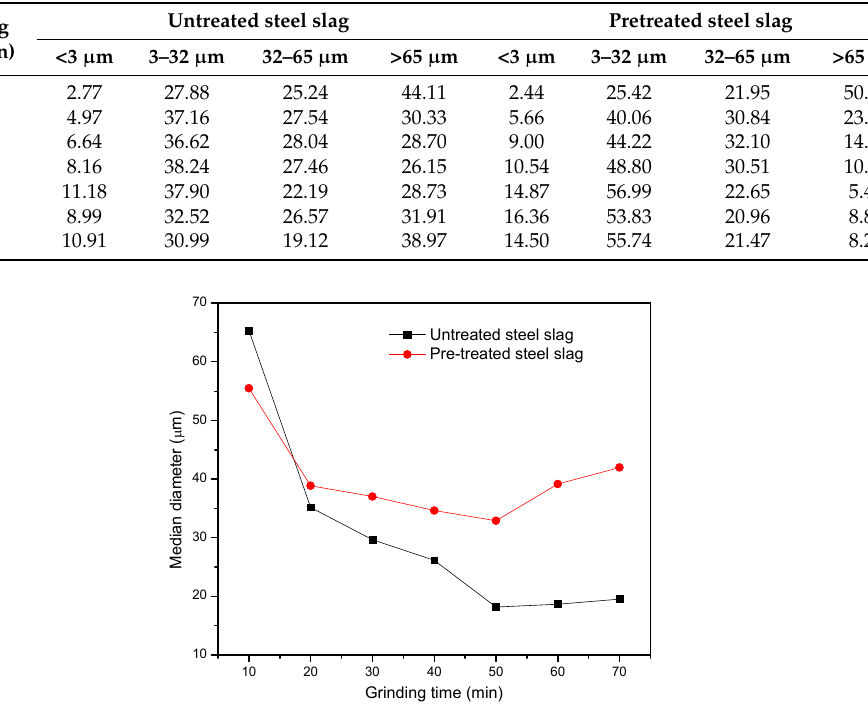
Figure 7. Median diameter of ground steel slag powder under different grinding time.